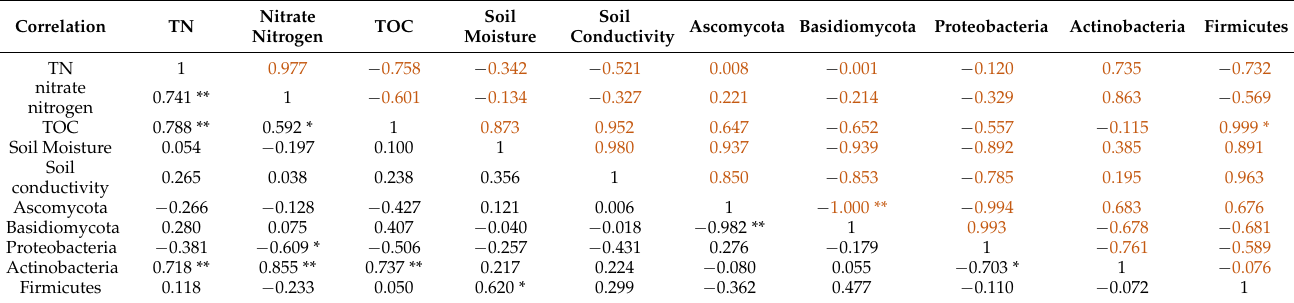
Table 6. Correlation analysis of soil physical and chemical properties and other